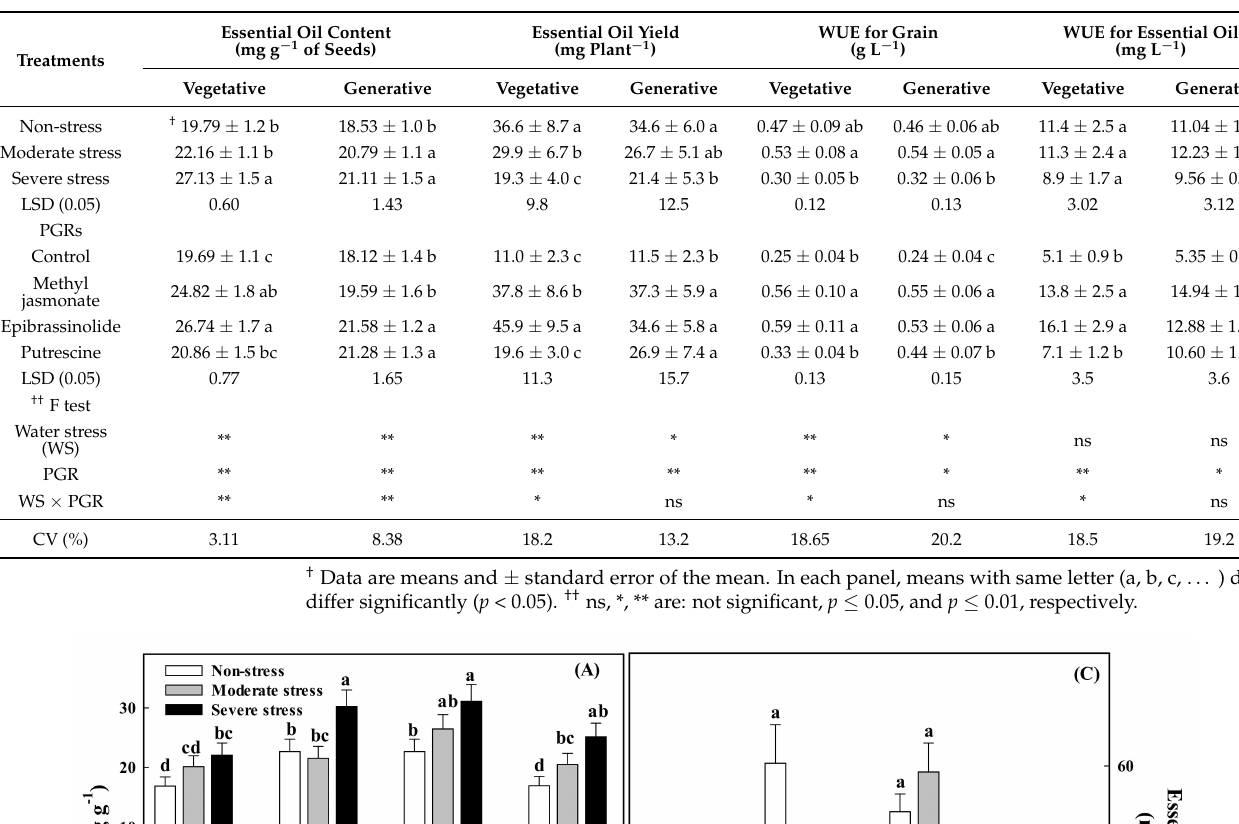
Table 3. Influence of water stress and PGRs application on essential oil content and water use efficiency of fennel ( Foeniculum vulgare Mill.) at two stages of the development.